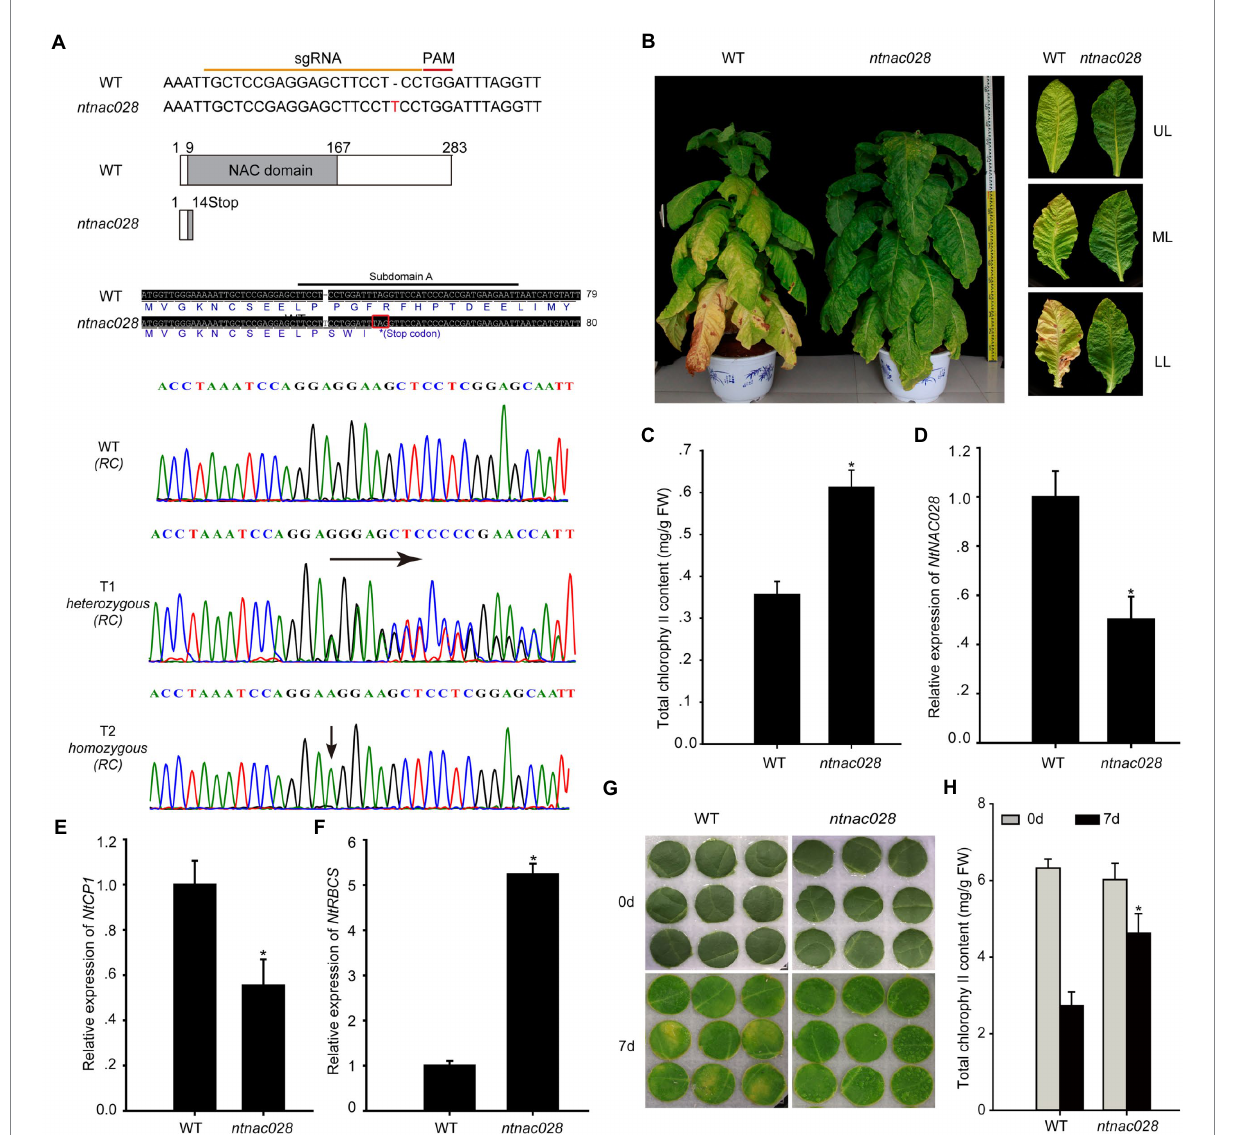
FIGURE 2 NtNAC028 positively regulates leaf senescence. (A) Construction of the NtNAC028 CRISPR-Cas9 vector. Sanger sequencing results showed an insert of 1 bp in the genomic DNA of ntnac028 , compared to the WT. Red line represents the PAM sequence. (B) Leaf senescence phenotypes of ntnac028 . (C) Chlorophyll content of middle leaves in age-matched wild-type (K326) and ntnac028 plants. UL (upper leaf), ML (middle leaf), and LL (low leaf). (D–F) Expression of NtNAC028, NtCP1, and NtRBCS in middle leaves of WT and ntnac028 . (G) Phenotypes of detached leaves under dark conditions. (H) Chlorophyll content of detached leaves in WT and ntnac028 under darkness for 7 days. The bars are SD of three biological replicates. Asterisks indicate statistically significant difference from WT (* p <